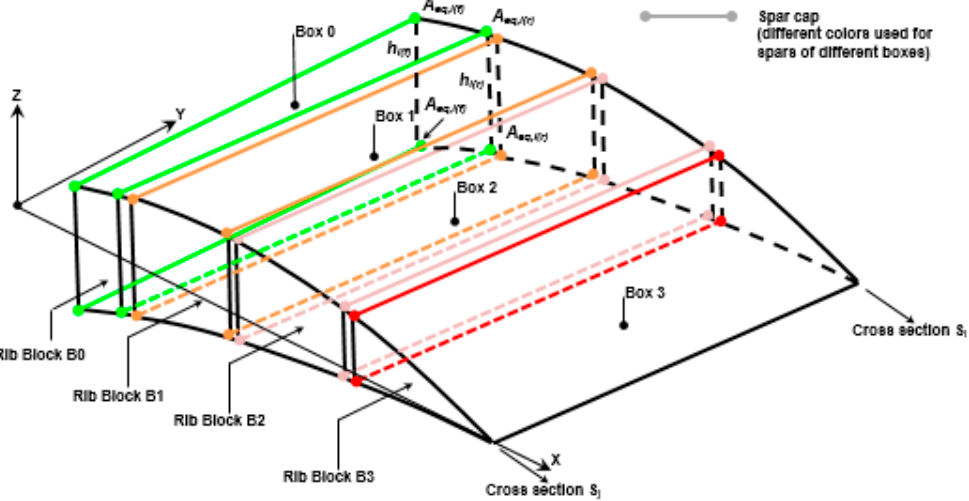
Figure 5. Multi-box structural discretization for the sizing purpose.